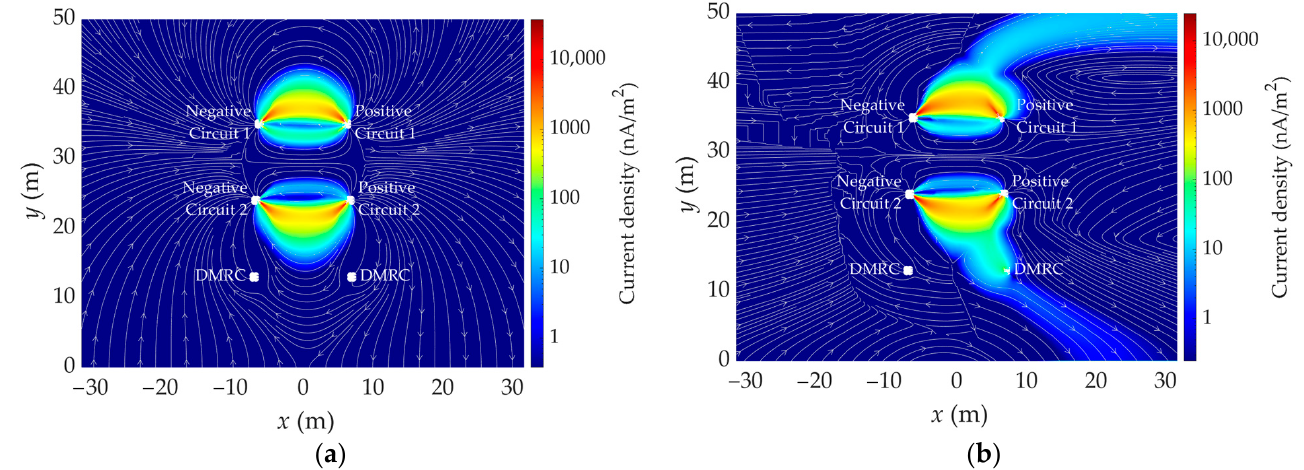
Figure 9. Ion current density distribution of the ±500 kV configuration with DMRC: ( a ) in the absence of wind; ( b ) in the presence of wind with average α .